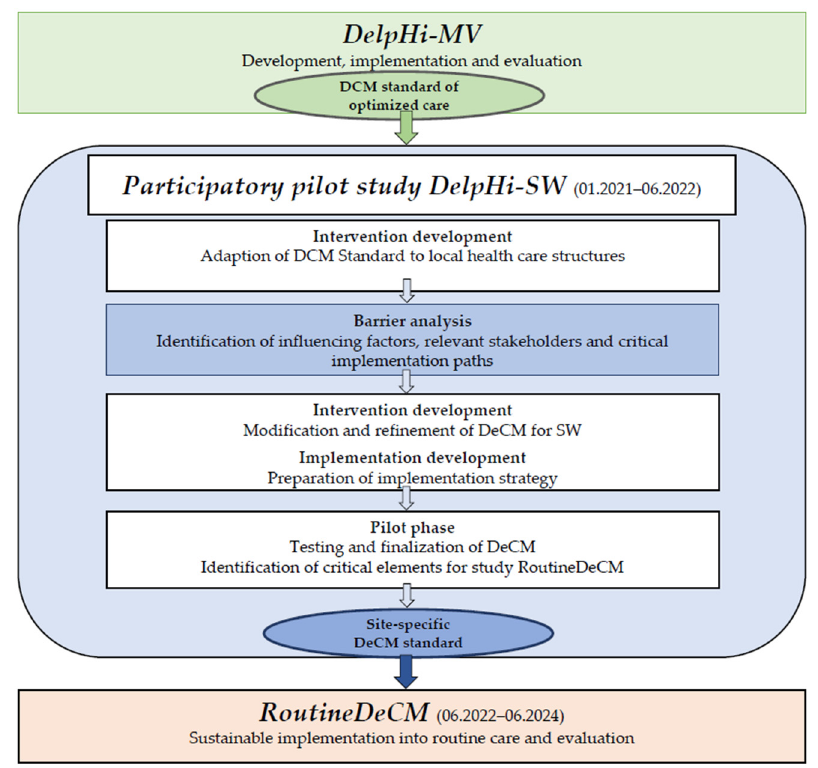
Figure 1. Embedding of the barrier analysis.